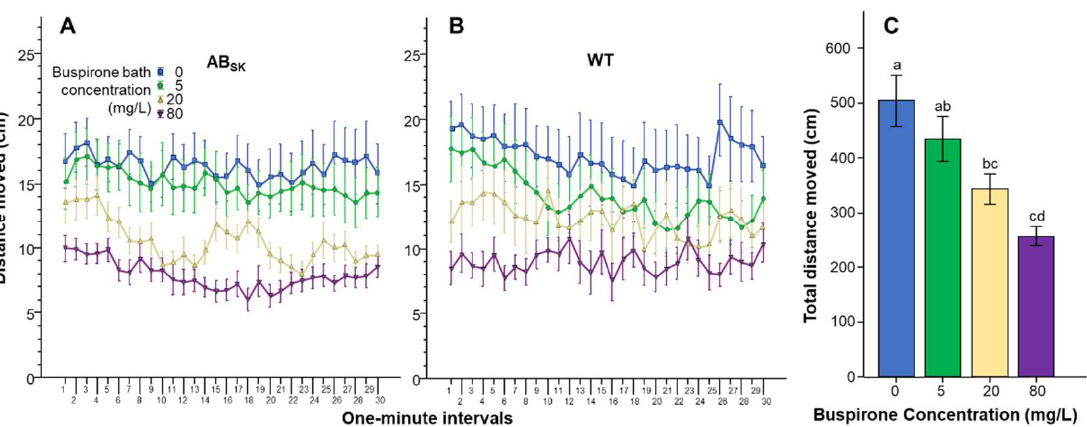
Figure 1. The distance fish moved is dose dependently reduced by buspirone. Distance as a function of time (1-min intervals) is shown for ABSK ( A ) and WT ( B ) zebrafish. The legends show the buspirone concentrations employed (blue line with rectangle 0 mg/L, green line with circle 5 mg/L, yellow line with triangle 20 mg/L, and purple line with upside down triangle 80 mg/L). ( C ) shows the cumulative (total) distance moved across the entire 30 min recording session, pooled for the two populations, by the zebrafish exposed to the different concentrations of buspirone (indicated underneath the X axis and also by the same color coding as in ( A , B ). Means + S.E.M. are shown. The results of Tukey HSD test are shown as letters above each bar of the bar graph ( C ). Bars that do not share one letter in common represent buspirone treatment groups that are significantly ( p < 0.05) different from each other. For detailed results of statistical analyses, see Results.